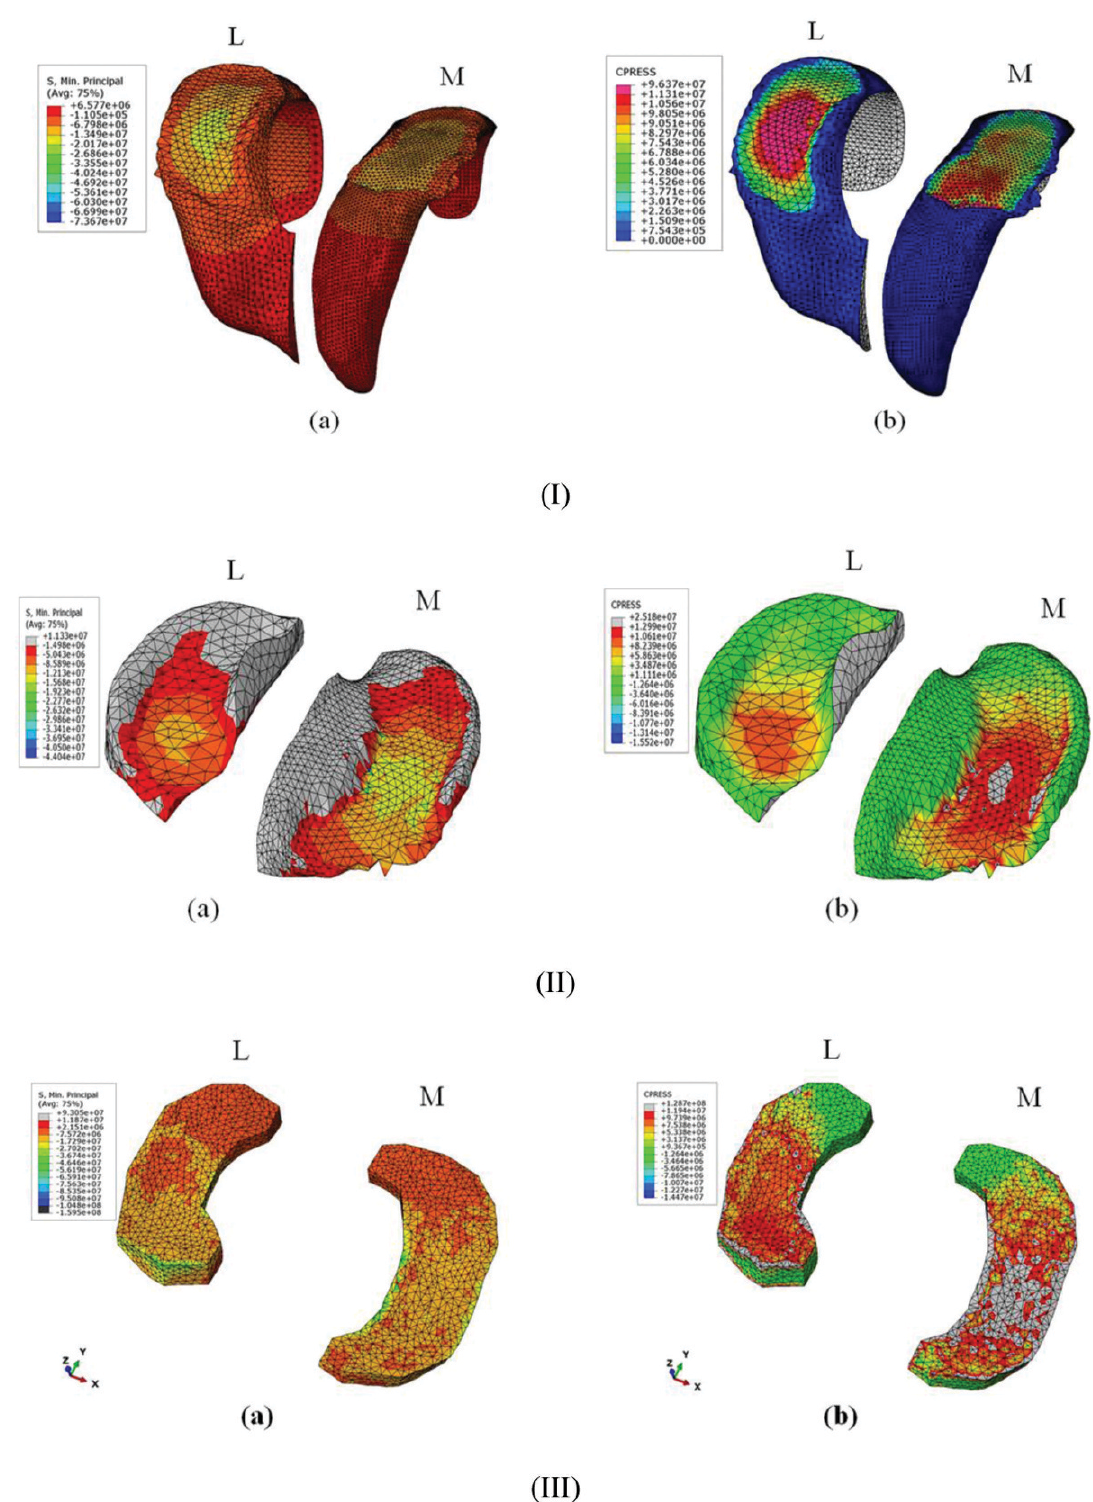
Figure 4 - I) Maximum stress on the femoral cartilage and b) the contact pressure on the femoral cartilage; II) a) the maximum stress on the tibial cartilage and b) the contact pressure on the tibial cartilage; III) a) the maximum stress on the meniscus and b) the contact pressure on the